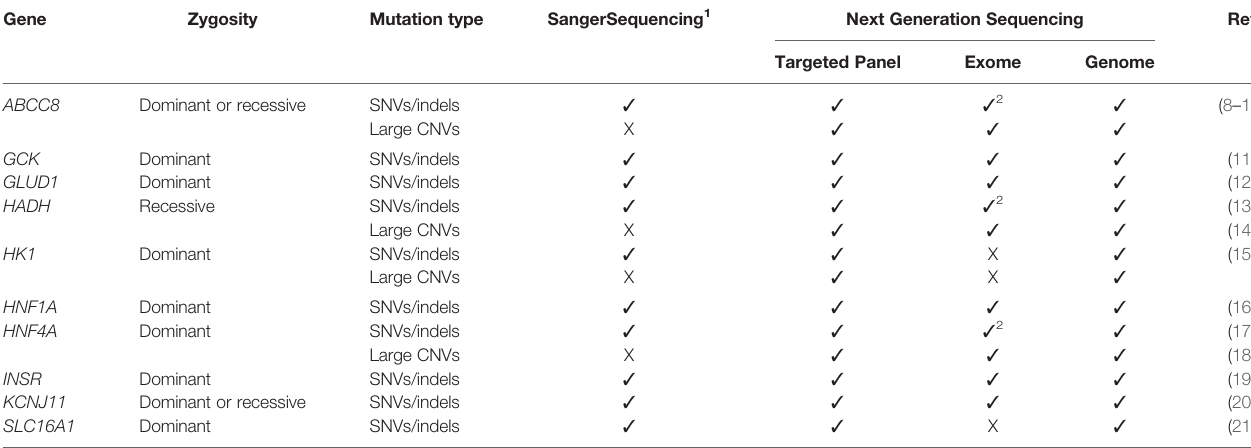
TABLE 1 | Known genetic causes of isolated congenital hyperinsulinism and current approaches to genetic testing for this condition. A tick ( ✓ ) or cross (X) denote whether the form of genetic variation can be detected by the screening approach. None of the variants listed will be detected by methylation studies or array-CGH analysis. SNVs are single nucleotide variants, Indels are insertion/deletion variants and CNVs are copy number variants (deletions and